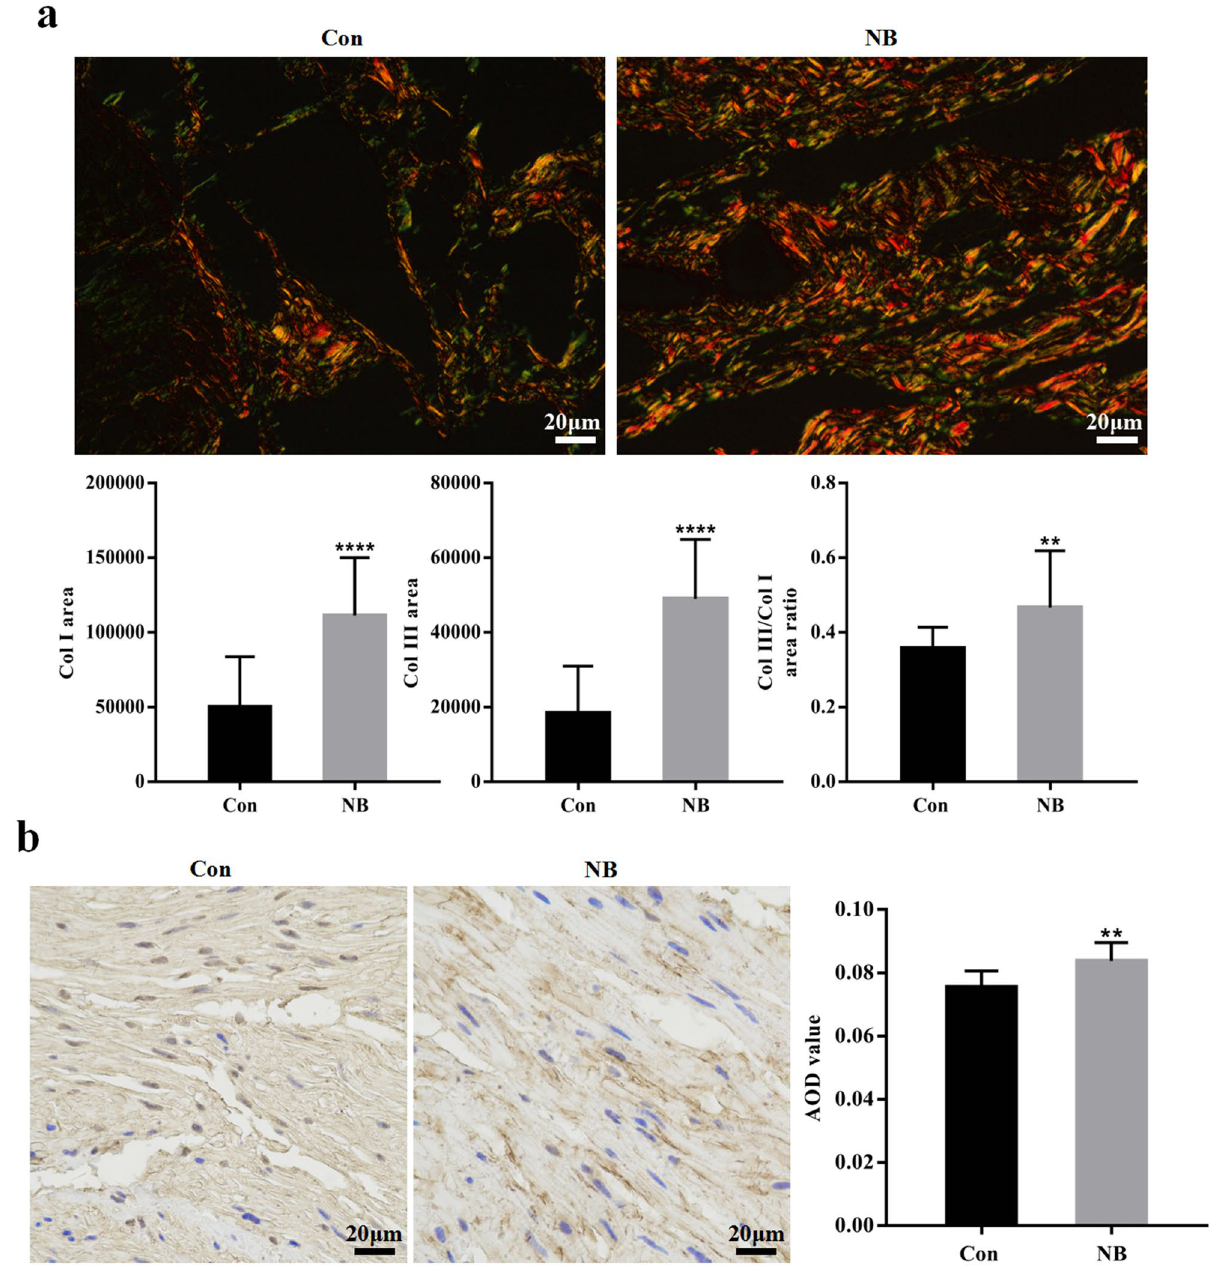
Figure 3. Specific staining of fibrosis-related proteins: ( a ) Sirius red staining of the two groups observed with a polarized light microscope. The orange or bright red crude fibres in the picture indicate Col I and the fine green fibres indicate Col III. The areas of collagen I and collagen III and the area ratios of collagen III to collagen I were compared between the two groups. ( b ) Immunohistochemical staining of FN. The brownish-yellow area in the figure indicates positive FN staining. The AOD values were compared between the two groups. The bars indicate 20 μm. The data are shown as the means ± SD. ** p < 0.01; **** p < 0.0001 versus the control. Student’s t test. AOD, average optical